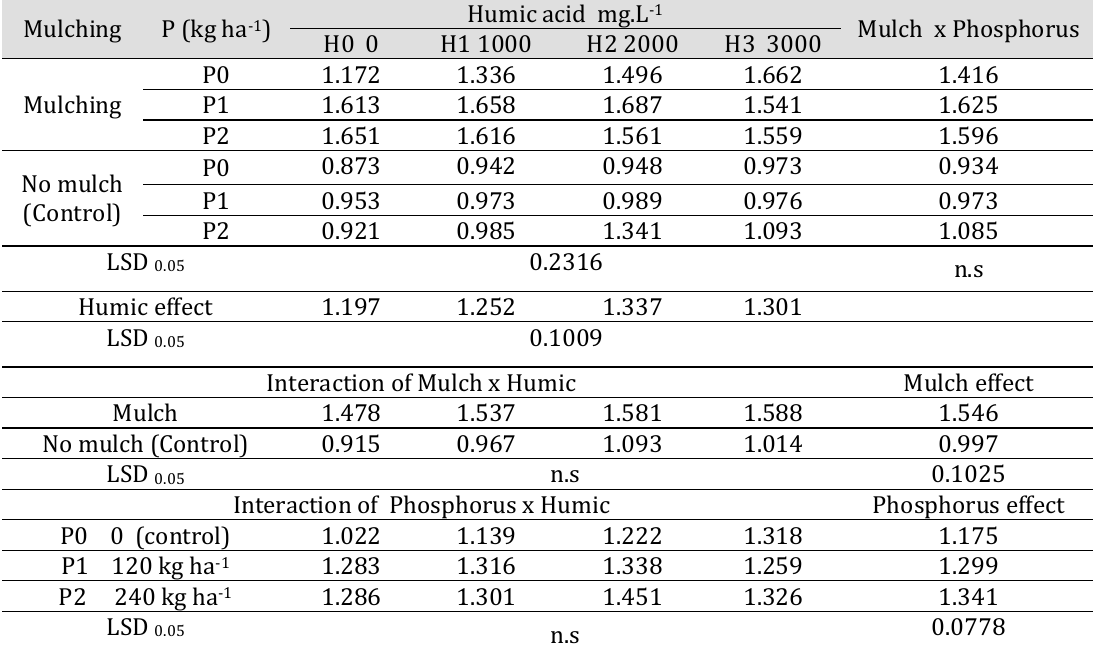
Table 4. Effect of soil mulching, phosphorus, and humic acid on leaf area index.